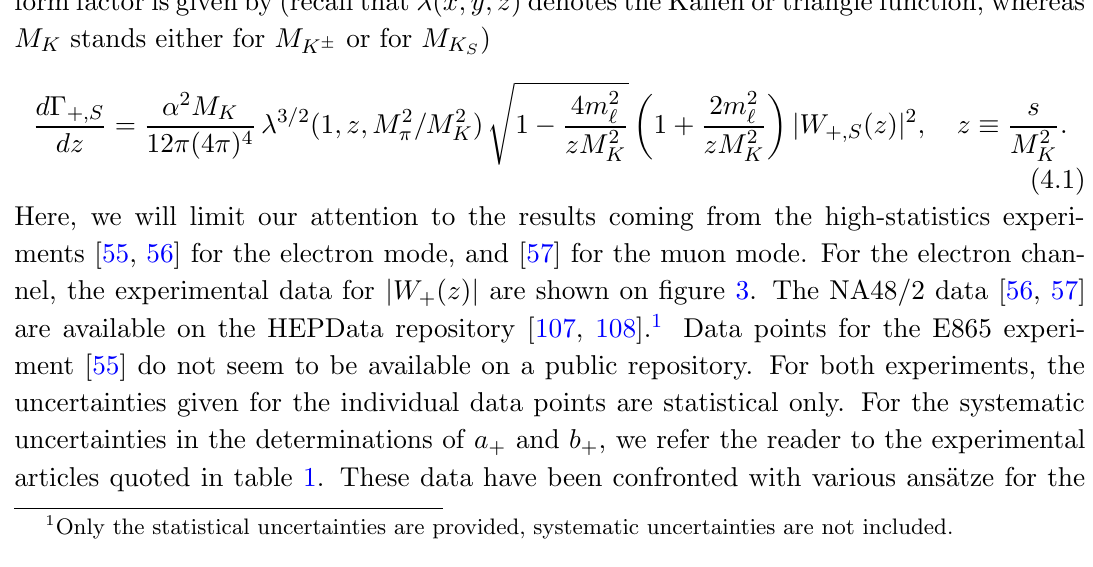
Figure 3 . The left-hand plot shows the data for from the NA48/2 experiment [56] ((cid:12)lled squares, in blue) and from the BNL-E865 experiment [55] ((cid:12)lled circles, in red). The right-hand plot shows the same data, but with the error bars of two points, one for each experiment, around z = 0 : 3, rescaled by a factor of 2.35. Throughout, only the statistical uncertainties are